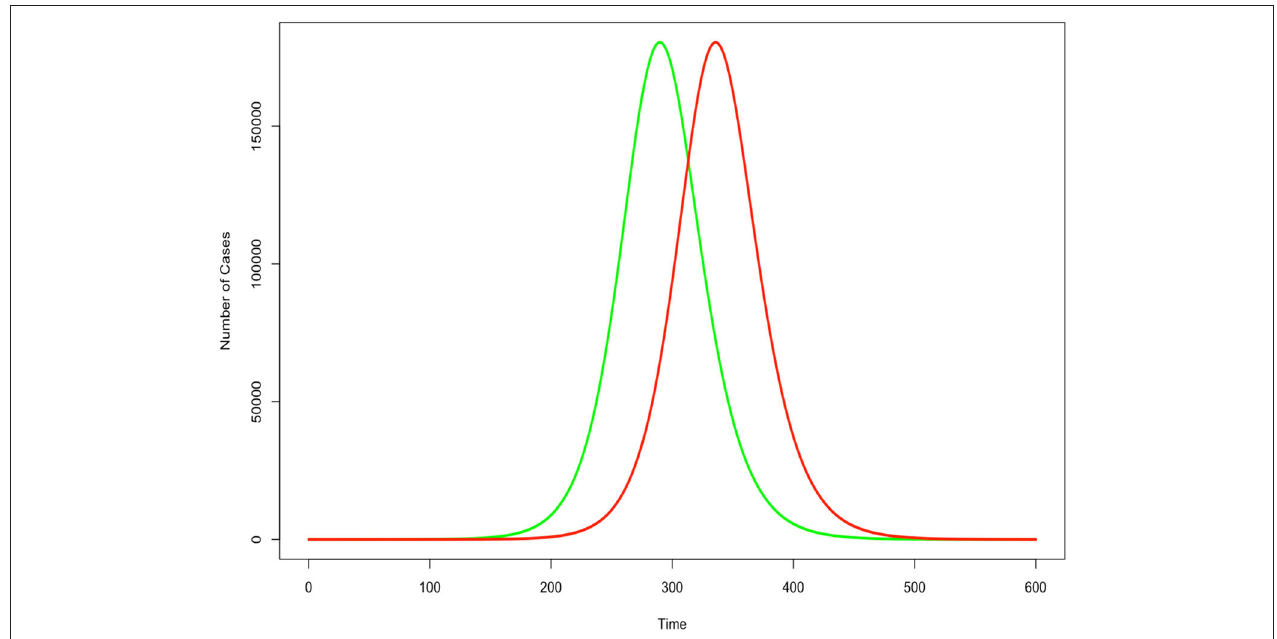
FIGURE 1 | Impact of underestimated case count in an SIR epidemic model. Green indicates correct count for initial condition. Red indicates undercount. All other factors held constant.